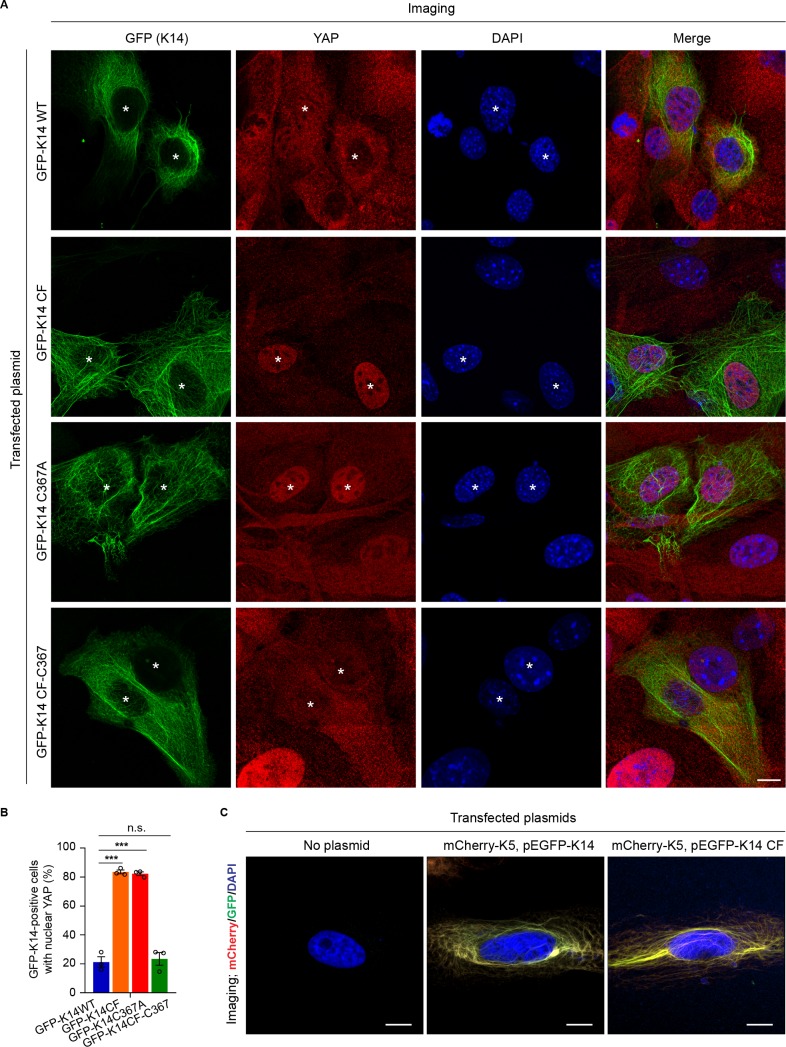
Localization of YAP is specifically regulated by cysteine residue 367 in human K14.Newborn skin keratinocytes from Krt14 null mice were seeded in primary culture, transiently transfected with either GFP-K14 WT, GFP-K14CF, GFP-K14C367A or GFP-K14CF-C367 constructs, and cultured in 1 mM calcium for 36 hr prior to analysis. (A) Indirect immuno-fluorescence showing successfully transfected and viable cells (see asterisks). Scale bar, 20 µm. (B) Quantitation of the percentage of GFP-K14 transfected cells with nuclear YAP staining. N = 3 biological replicates. N = 100 cells were counted for each genotype and each construct. Data represent mean ± SEM. Student’s t test: ***p<0.005; n.s., no difference. (C) Organization of keratin filaments in HeLa cells transiently co-tranfected with no plasmid (left), mCherry-K5 (WT) and pEGFP-K14 (WT) (center), and mCherry-K5 (WT) and pEGFP-K14 CF (right). Nuclei are stained with DAPI. Scale bars, 20 µm.